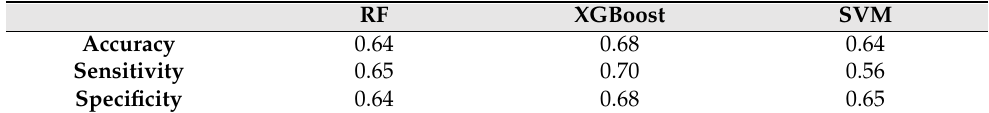
Table 6. Model performances. Accuracy (proportion of the data that are predicted correctly). Sen- sitivity (proportion of positive results out of the number of samples, which were actually positive). Specificity (proportion of negatives that are correctly identified as negatives). RF = Random Forest, XGBoost = Extreme Gradient Propulsion and SVM = Support Vector Machine.